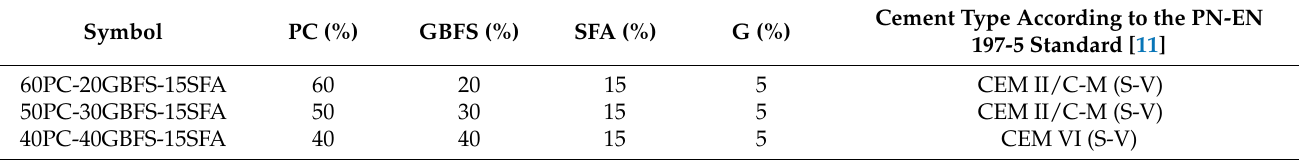
Table 2. Compositions of the cement mixtures studied.